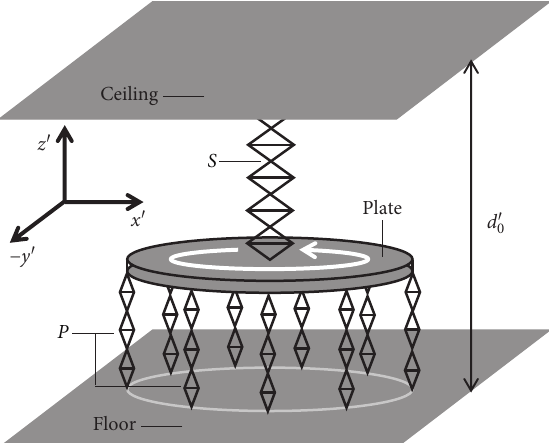
Figure 1: A multispring system as viewed in the lab frame of reference. The P springs are set in parallel to each other and in series with S . The rotating plate makes the P springs rotate along with it at u ′